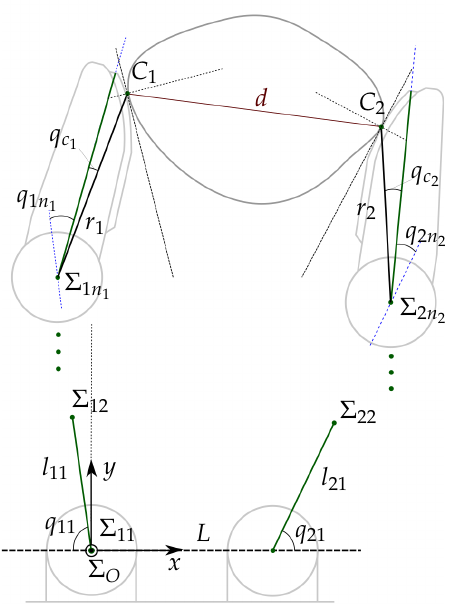
Figure 1. Geometric model of a two-finger